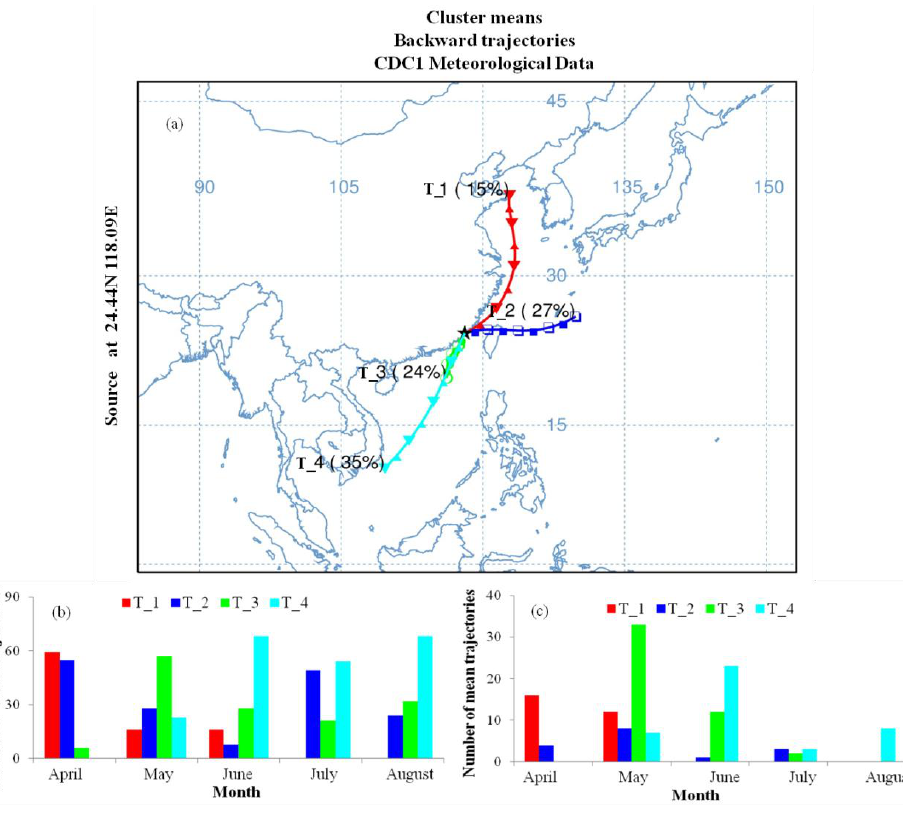
Figure 3. Cluster analyses of 96-h backward trajectories ending at the sampling site: ( a ) cluster mean trajectories from April to August 2014; ( b ) monthly distributions of the four mean trajectories during the sampling period; and ( c ) monthly distributions of the four mean trajectories during the sampled precipitation events.